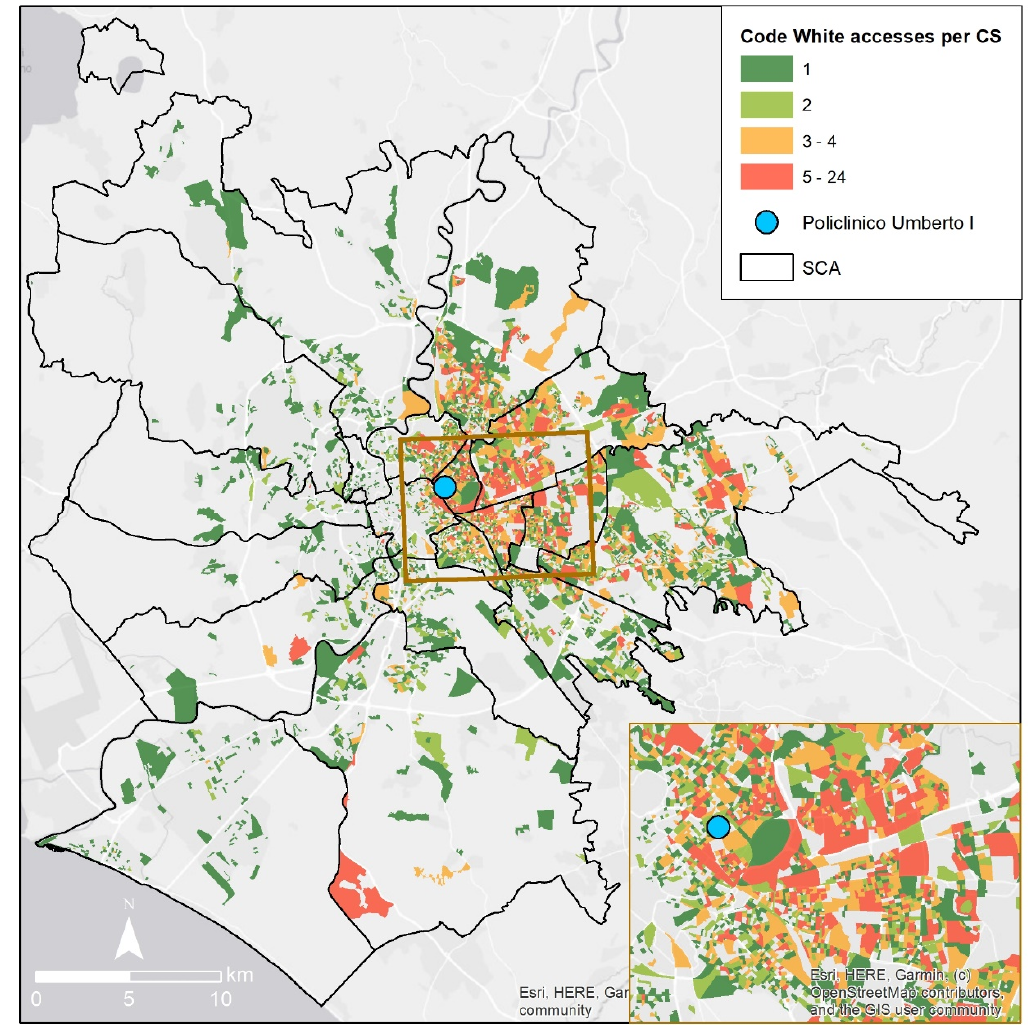
Figure 3. Accesses in code white recorded by the Policlinico Umberto I emergency room with data aggregated on the basis of census sections. Source: authors’ elaboration.